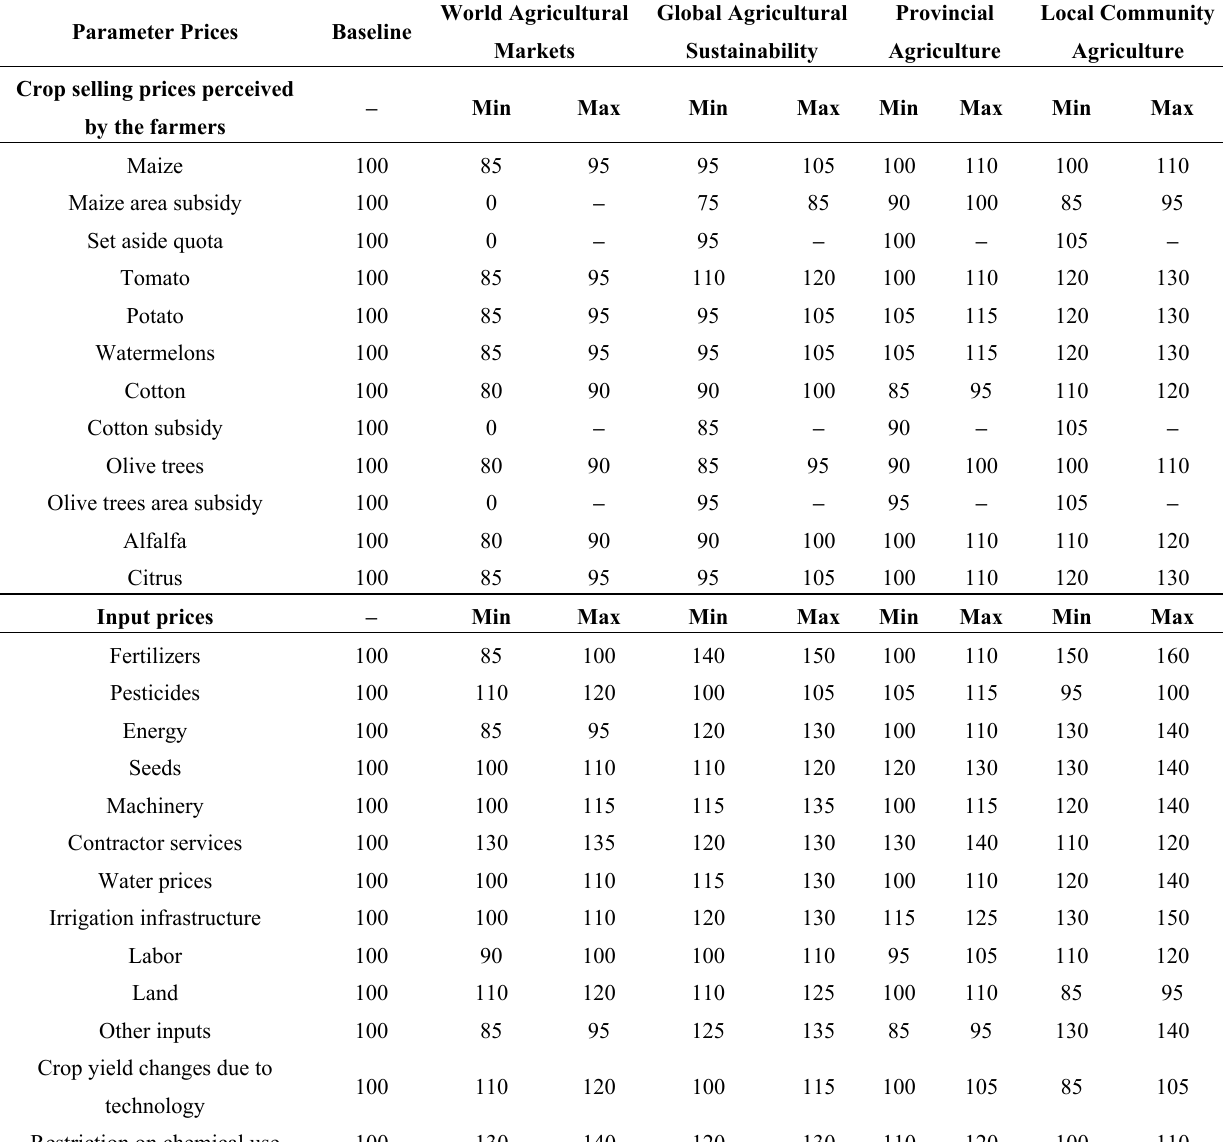
Table 12. Analysis of the Foresight scenarios based on the regional analysis in [17,18] Expressed as a percentage of the baseline year at constant